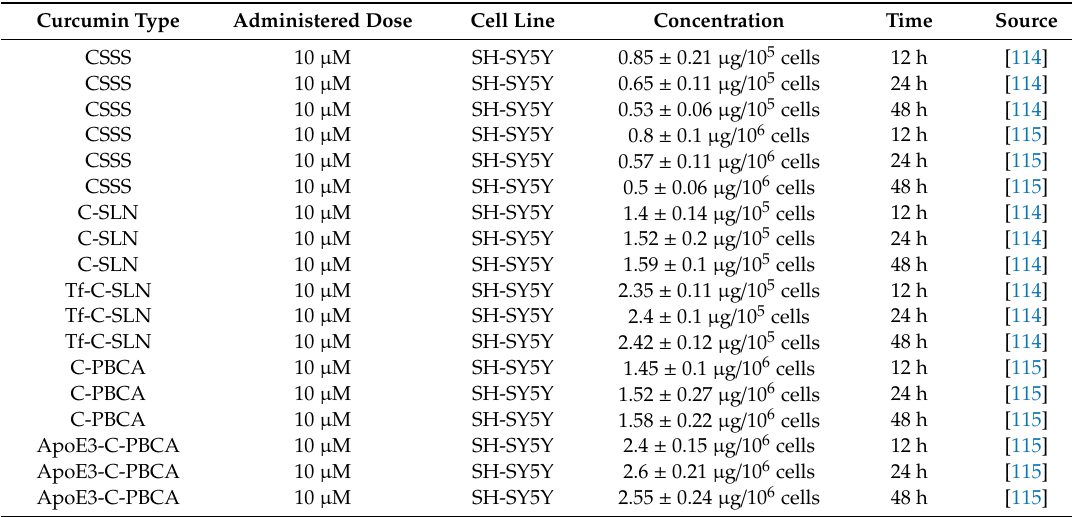
Table 4. Cellular uptake of several curcumin formulations, including suspension, nanoparticles, and protein-conjugated nanoparticles. The protein-conjugated nanoparticles (ApoE3-C-PBCA and Tf-C-SLN) utilize receptor-mediated endocytosis to enter NB cells and exhibit greater uptake over time than curcumin-solubilized surfactant solution (CSSS) and the corresponding non-protein-conjugated